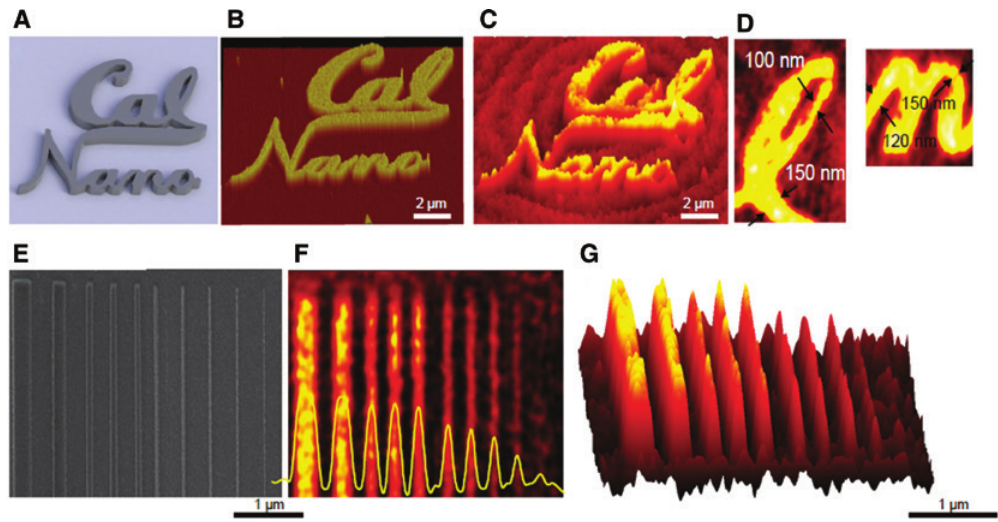
Figure 3: PBM can image three-dimensional topology of complex shapes with 30 nm feature size. (A) Schematics of an extruded “CalNano” shape fabricated out of PMMA by e-beam lithography. The surface of the PMMA is 120 nm above the sapphire surface. (B) AFM image shows also a few NPs stuck to the sample after an experiment. (C) Three-dimensional PBM image in which the CalNano pattern’s geometry is clearly resolved. The whole 10 μ m × 10 μ m image was acquired by collecting 200,000 frames, each with an acquisition time of 3 ms. (D) Zoom-in highlighting the ability of PBM to resolve 100–150 nm features in the letters “l” and “n”. (E) SEM of fabricated lines with progressively decreasing width and height. The width of the lines, each separated by 100 nm, ranges from 120 nm on left-hand side to 20 nm on the right-hand side. (F) PBM image of the lines including the averaged cross section (yellow) showing that the smallest 30 nm line is clearly visible, while the 20 nm line is only barely visible. (G) Three-dimensional reconstruction of the line sample showing both the varying thickness of the lines, all the way down to the 30 nm line, and the decreasing height of the